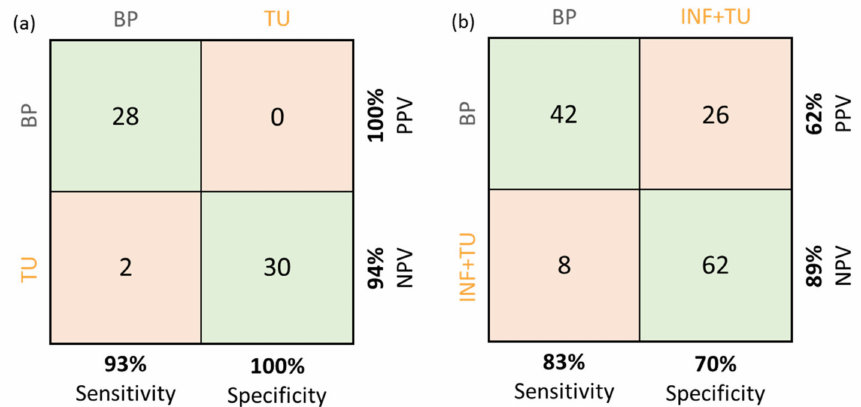
Figure 5. Contingency tables for both CNNs trained in this study. ( a ) Contingency table with positive predictive values (PPV) and negative predictive values (NPV) for the network trained on tumor (TU) and non-neoplastic brain parenchyma (BP) tissue B-scans. ( b ) Contingency table with PPV and NPV for the network trained on both infiltration zone and tumor (INF + TU) as compared to non-neoplastic tissue